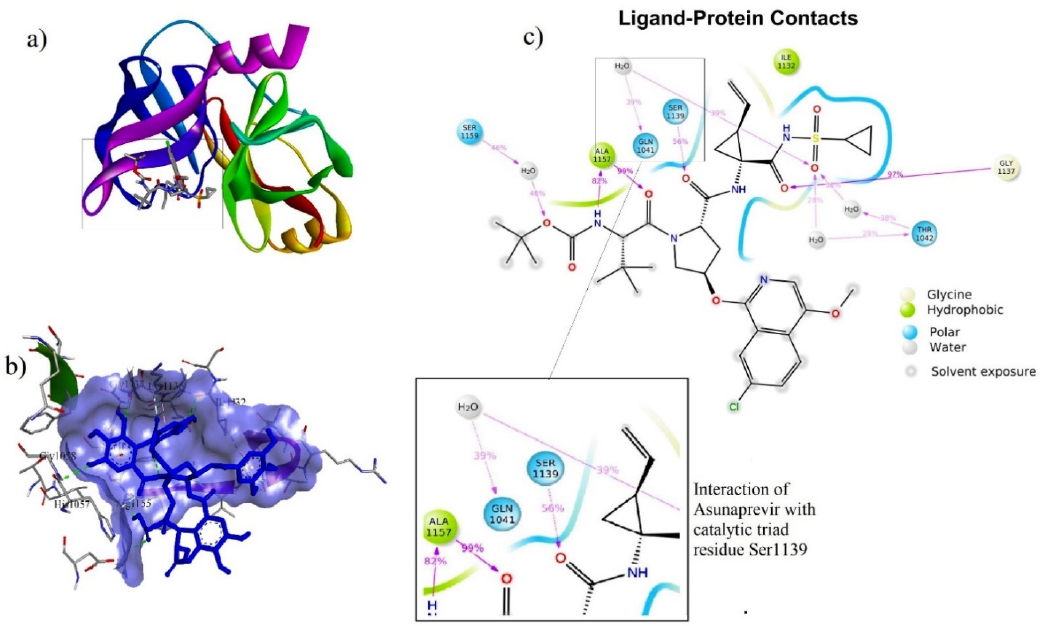
Figure 6. Intermolecular Interactions of Asunaprevir with NS3/4A. ( a ) Asunaprevir at catalytic triad residue site; ( b ) Asunaprevir at NS3/4A binding pocket; ( c ) Asunaprevir interaction with catalytic triad residue Ser1139.